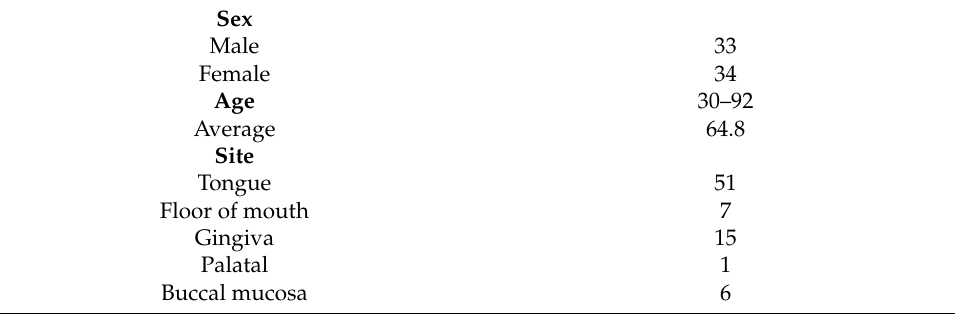
Table 1. Clinical characteristics of the